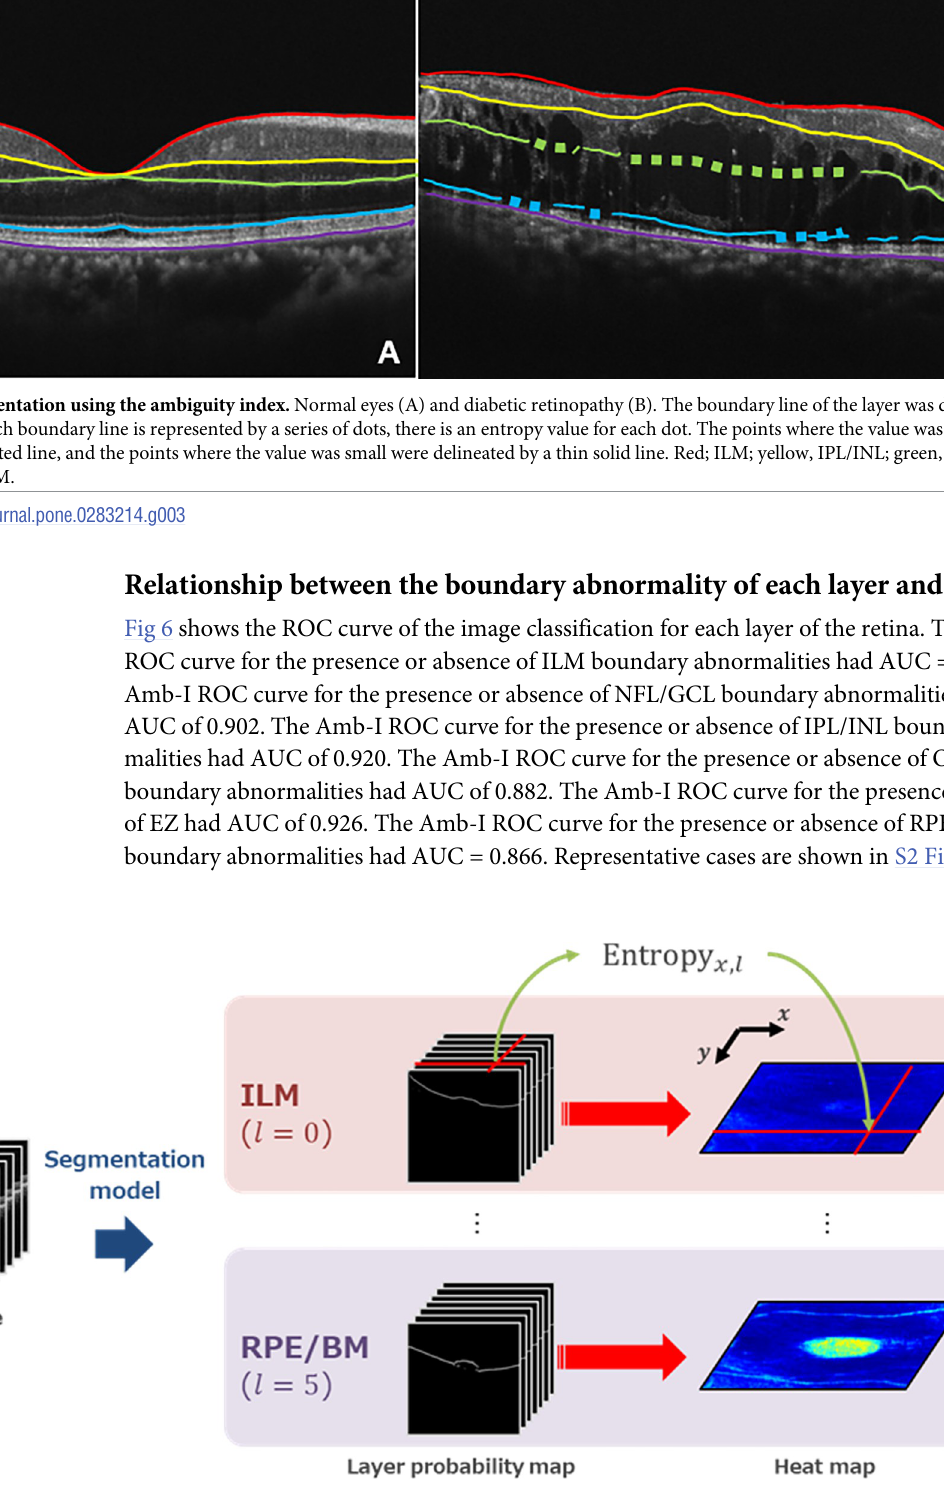
Fig 4. Scheme of ambiguity map productive process. By calculating entropy in the volume scan, it is possible to create a heatmap for each layer of the retina and visualize the part with high entropy.